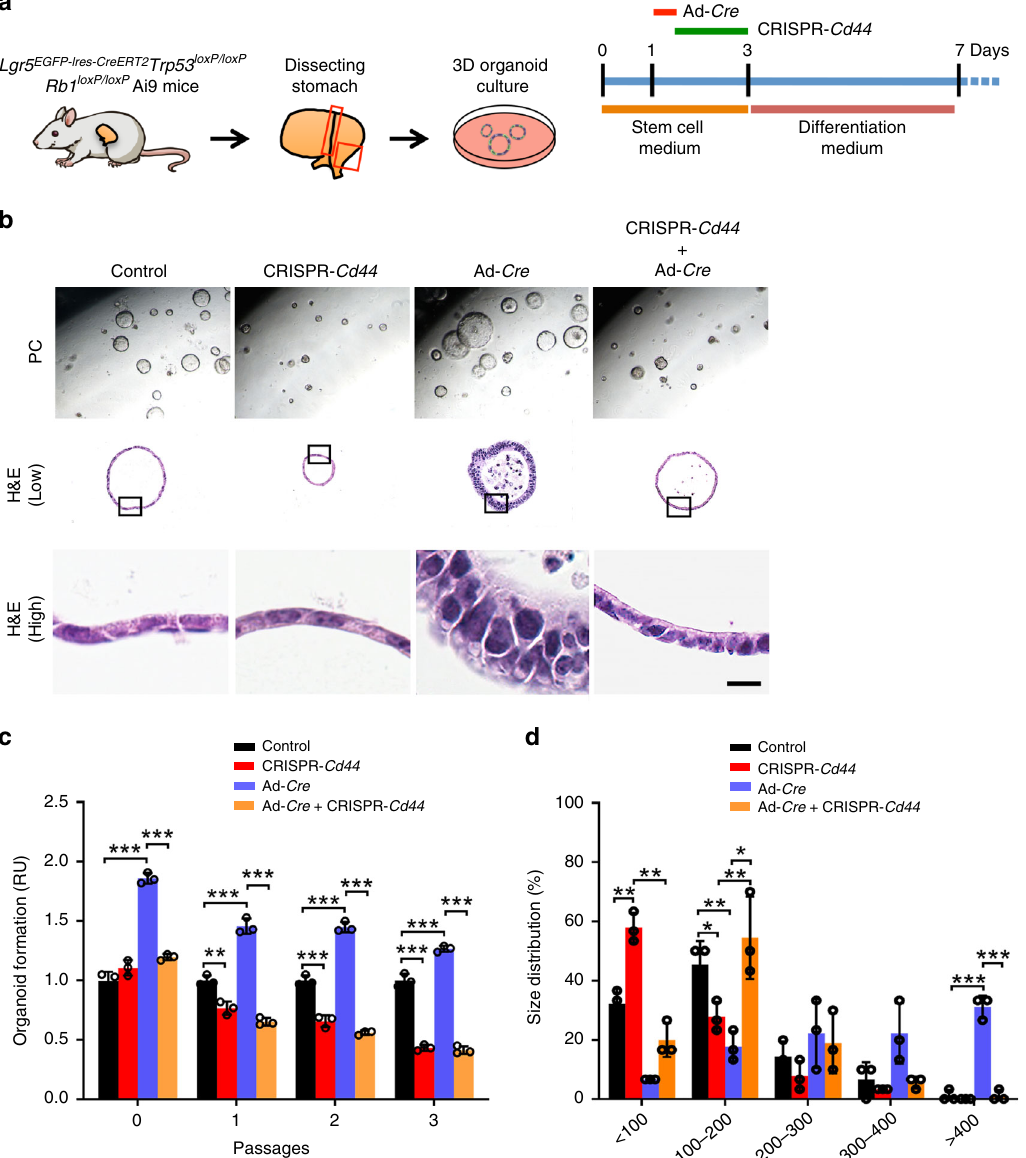
Fig. 4 The role of CD44 in the growth and transformation of gastric organoids. a Experimental design. The rectangles indicate regions used for organoid preparation. b Organoids formed by gastric epithelial cells derived from Lgr5 eGFP − Ires − CreERT2 Trp53 loxP/loxP Rb1 loxP/loxP Ai9 mice before (control) and after deletion of CD44 (CRISPR- Cd44 ), Trp53 , and Rb1 (Ad- Cre ) or all three genes (CRISPR- Cd44 + Ad- Cre ). Rectangle in middle row images indicates area shown in bottom row images. The relative numbers ( c ) and sizes ( d ) of gastric organoids before and after inactivation of Trp53 and Rb1 (Ad- Cre ) and/or CD44 (CRISPR- Cd44 ). The organoid numbers were normalized to control organoids at the same passage. The scale bar represents 500 μ m ( b , top panels), 70 μ m ( b , middle panels), and 9 μ m ( b , bottom panels). * P < 0.05, ** P < 0.01, *** P < 0.001, two-tailed unpaired t -tests. All error bars denote s.d. Source data are provided as a Source Data fi